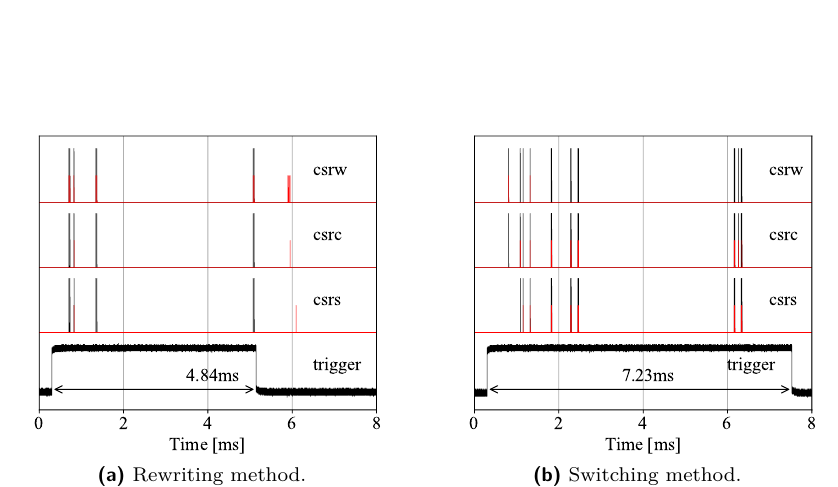
Figure 22: Identified and true execution timing. Black and red lines show the results from template matching and GPIO, respectively.